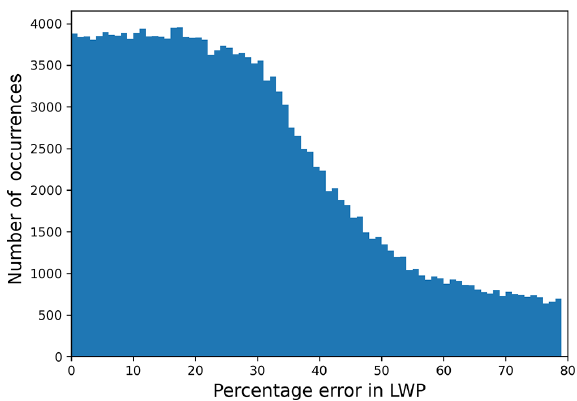
Figure 15. Percentage error in retrieved LWP with respect to LWP measured by MWR at